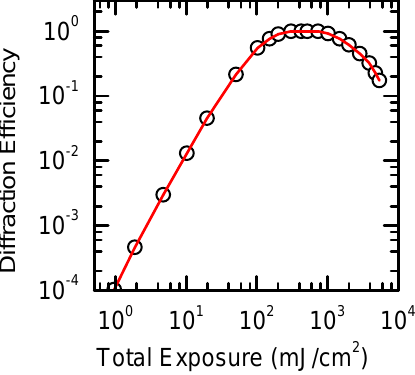
Figure 14. Diffraction efficiency of holographic grating recorded at T = 100 K in CdF = 4 × 10 17 cm − 3 ) crystal vs. exposure. Recording and readout at λ = 453 ( N Ga